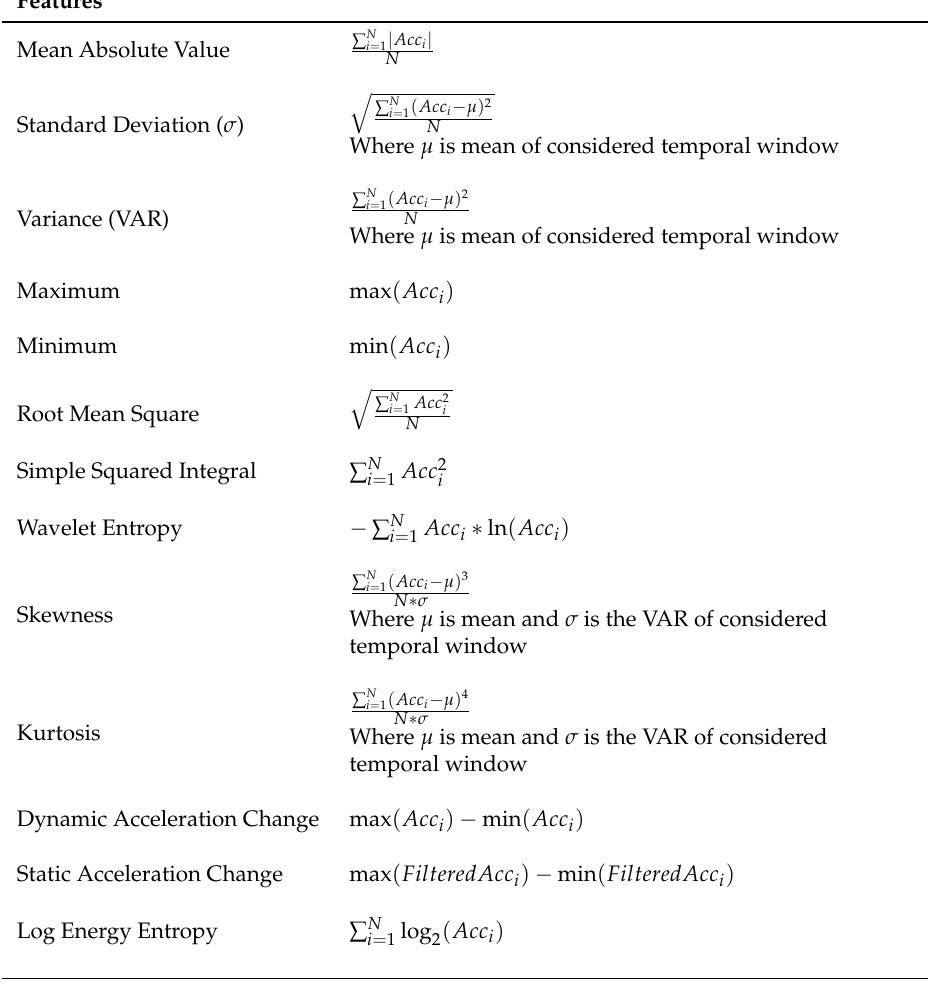
Table 2. Main Features of Shimmer3